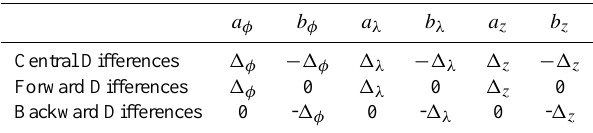
Table A1. Constants to be used with our finite-difference approxi- mations to the derivatives. For inner points, central differences are used. For the first point in the domain, forward differences are used, while for the last point backward differences are